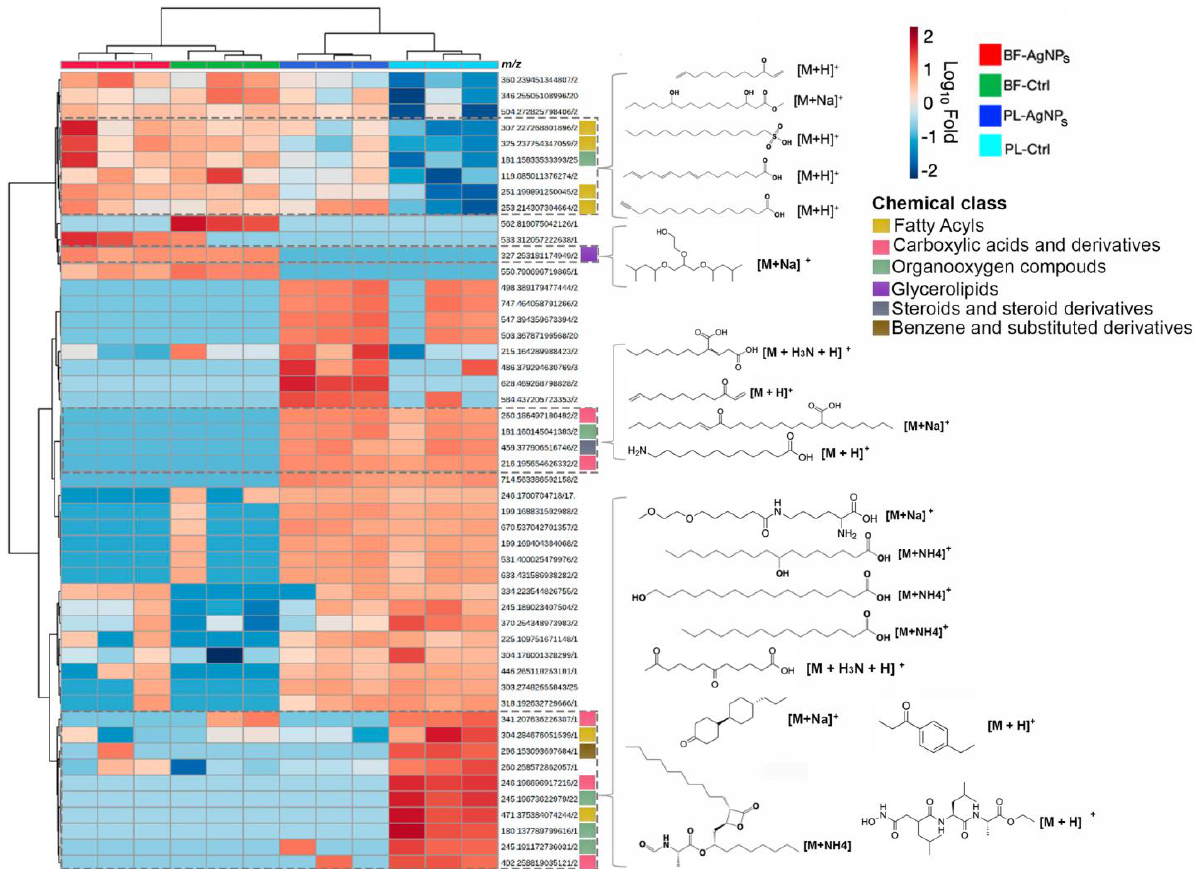
Figure 5. Heatmap and hierarchical clustering visualizations of the top 50 metabolites ranked by ANOVA, exhibiting the different metabolite abundances among the AgNP treatment and control groups. Chemical classes are shown in different colors, and on the right of the heatmap, the values of m/z of each metabolite are shown. Data were log-transformed without scaling for the heatmap analyses. The clustering method used was Ward, using Euclidean distance as a distance measure. (BF- AgNPs—Biofilm exposed to AgNPs; BF-Ctrl—Unexposed biofilm control; PL-AgNPs—Planktonic cells exposed to AgNPs; PL-Ctrl—Unexposed planktonic cells control; QC—Quality